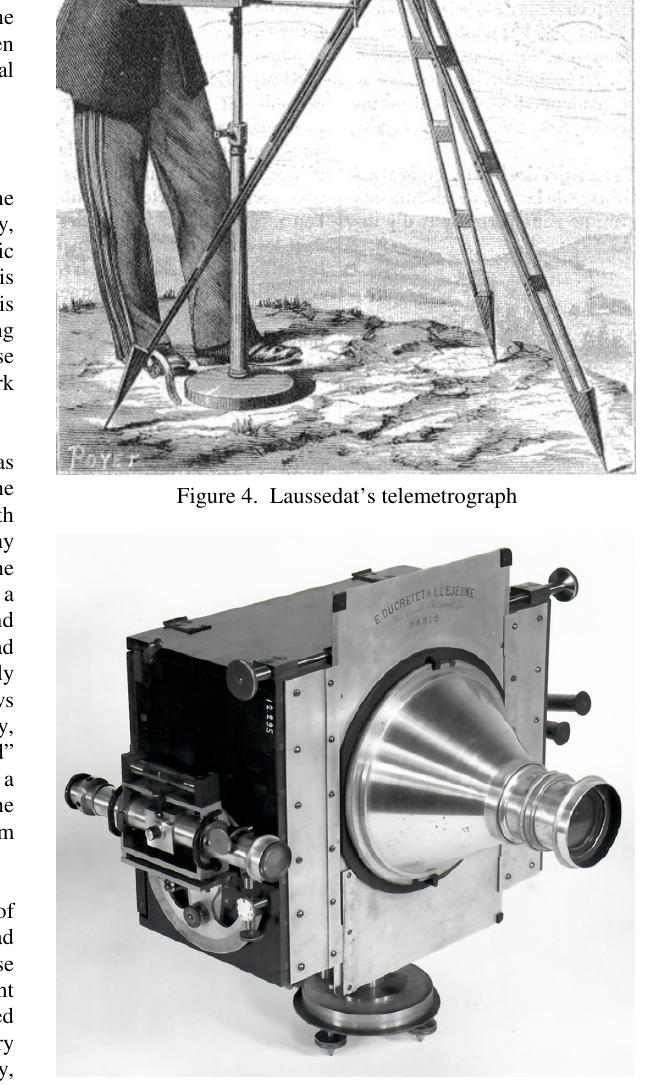
Figure 5. Laussedat’s